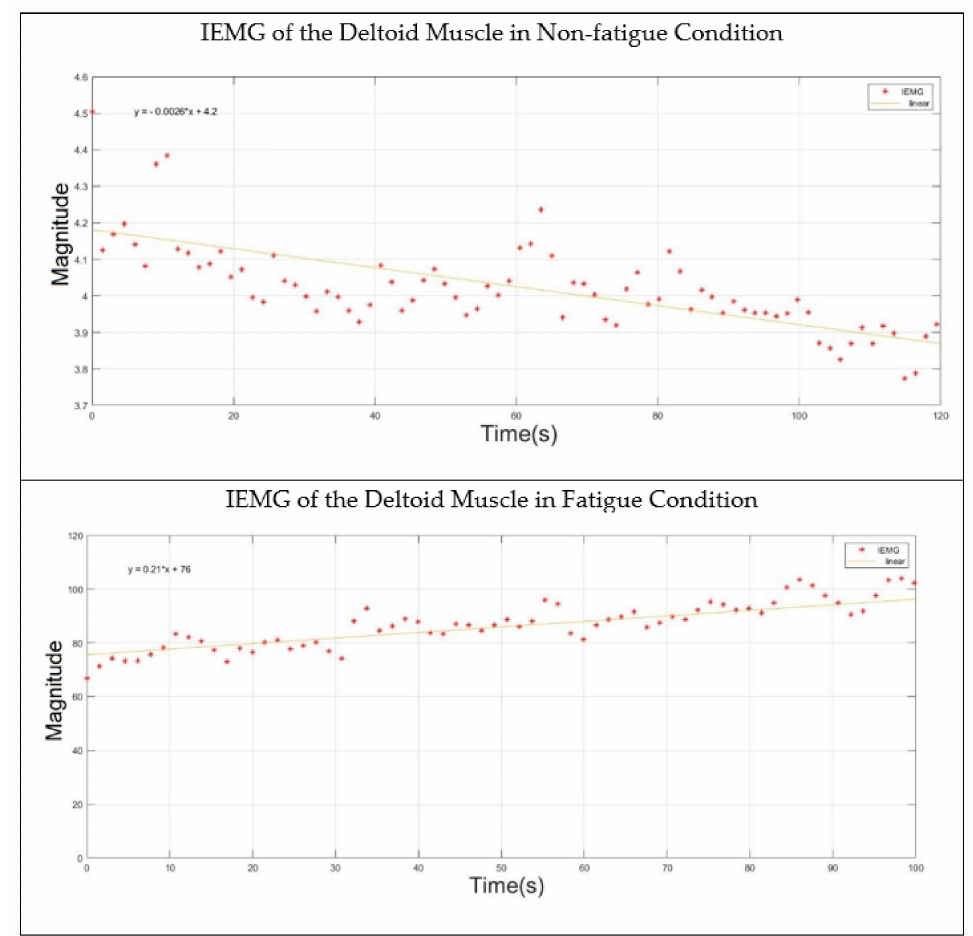
Figure 6. IEMG behavior of the deltoid muscle in non-fatigue and fatigue states. Second, the double-step binary classifier calculates the fatigue index based on the values of the instantaneous mean amplitude (IMA) of high-frequency and low-frequency sub-signals (HFSS and LFSS). Therefore, it was better to show how the IMA of the HFSS and LFSS behaved during the two muscle fatigue conditions (non-fatigue and fatigue). Figure 7 shows the IMA of both the HFSS and LFSS when the middle deltoid was in non-fatigue and fatigue conditions. In the non-fatigue condition, it was clearly shown that the IMA values of both the HFSS and LFSS were totally separated and the fatigue index exhibited a negative value. Hence, the fatigue did not progress. As mentioned in the previous section, even though the subjects performed no action while in the non-fatigue state, the middle deltoid muscle still played an important role in the stabilization of the shoulder joint, and ultimately produced a sort of sEMG